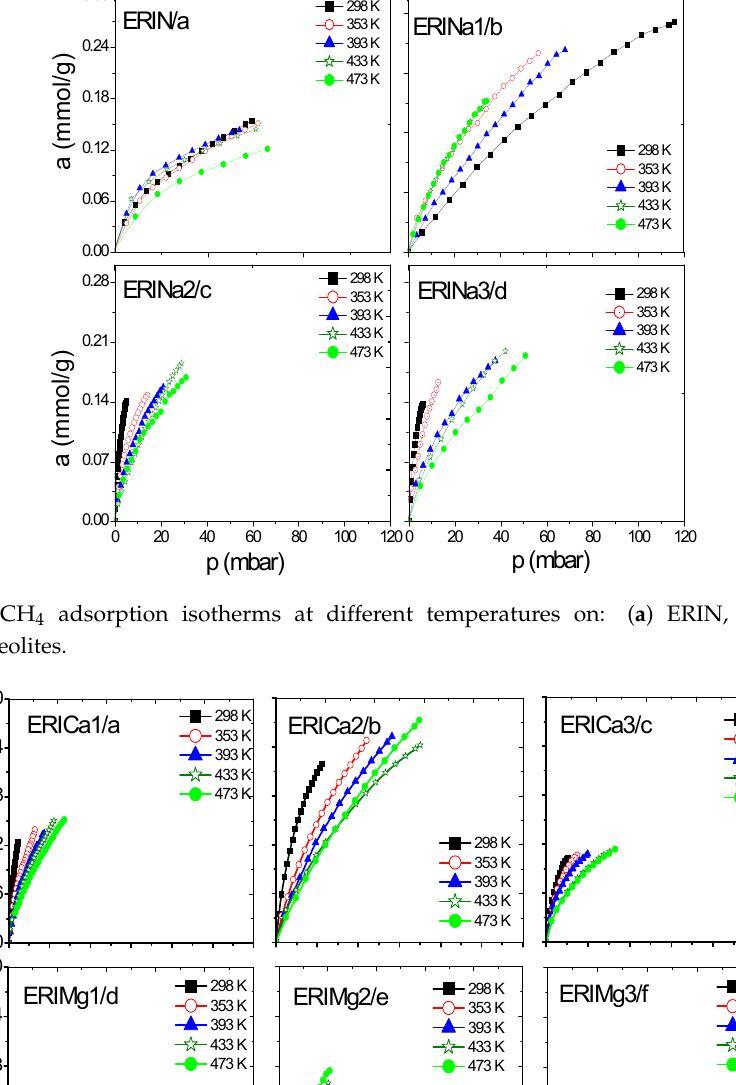
Figure 8. H 2 adsorption isotherms at different temperatures on: ( a ) ERIN, ( b – d ) ERINa1–3 exchanged zeolites. Figures 6a–d and 7a–f show a better adsorption capacity of CH 4 at room temperature in contrast with H 2 adsorption with the samples exchanged with Ca 2+ and Mg 2+ . In these samples, the highest adsorption values are shown above 433 K (Figure 9a–f). This last temperature is close to the value, where, according to the TGA analysis (Figure 5), the weight loss is associated with the evaporation of water molecules that are in coordination with exchange cations. It was reported that the dehydration of erionite zeolites has a direct relationship with the mobility of cations in the structure.